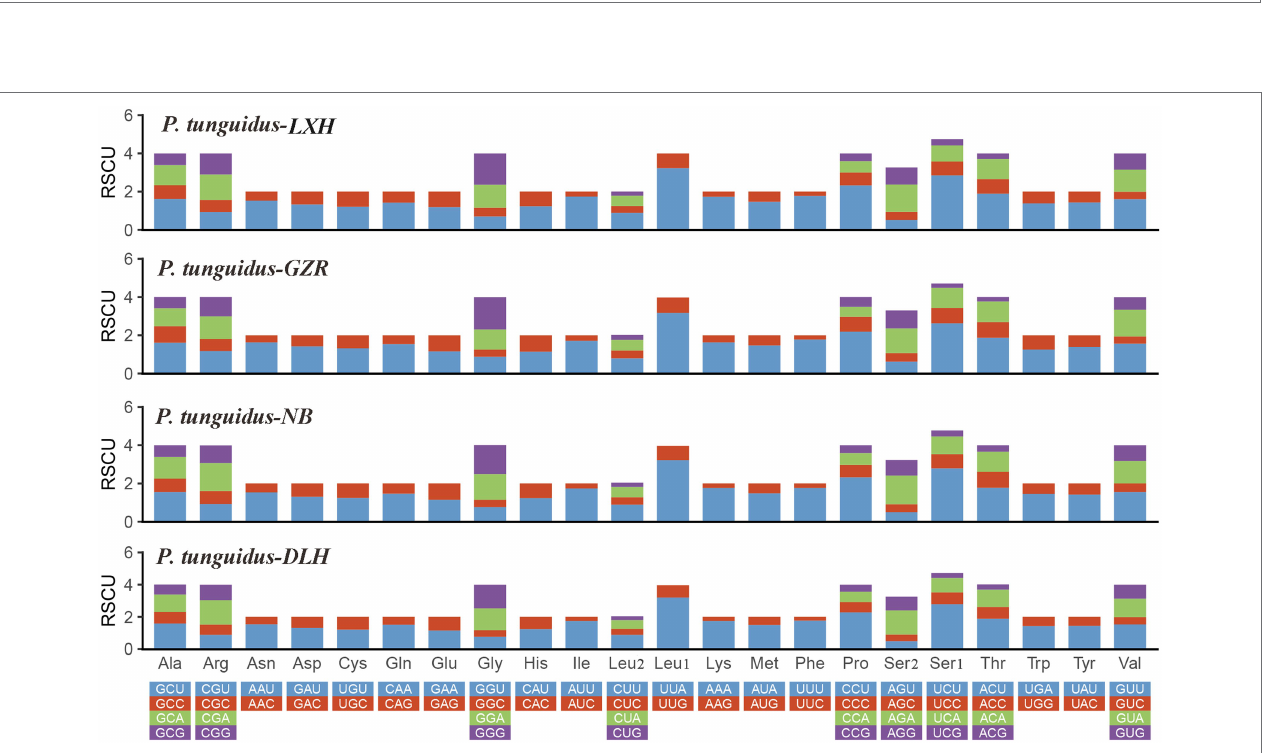
FIGURE 2 | The codon usage pattern for the four representative mitogenomes of P. tunguidus . The codon families are shown on the X -axis and CDsp T on the Y -axis.